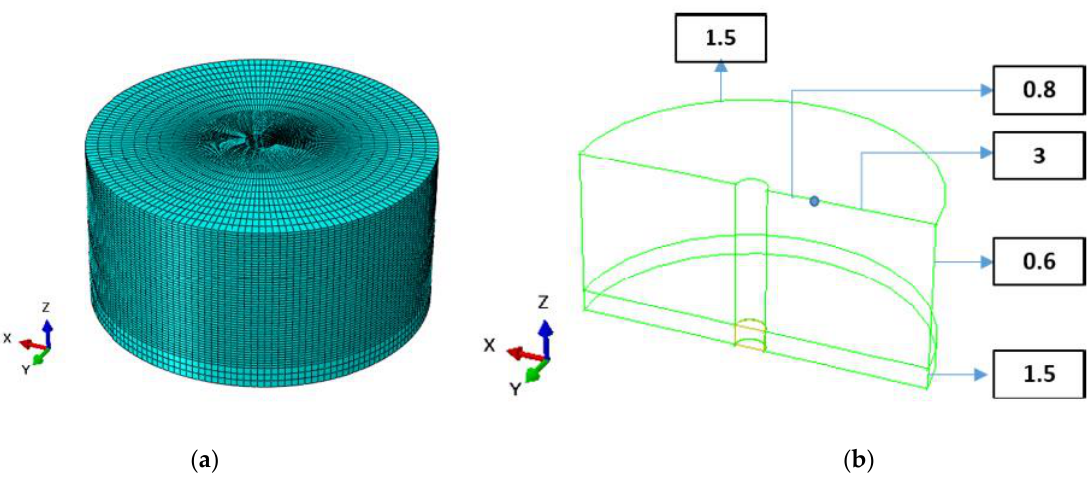
Figure 4. Global mesh of soil: ( a ) Soil’s mesh, ( b ) Mesh size. Soft clay: The Y oung’s modulus E of soft clay is 20 MPa, and the Poisson’s ratio υ is